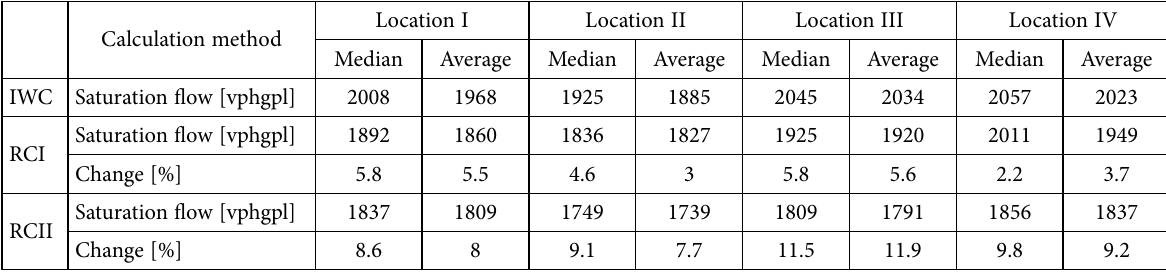
Table 2. Saturation flow rate reduction under the rain impact Calculation